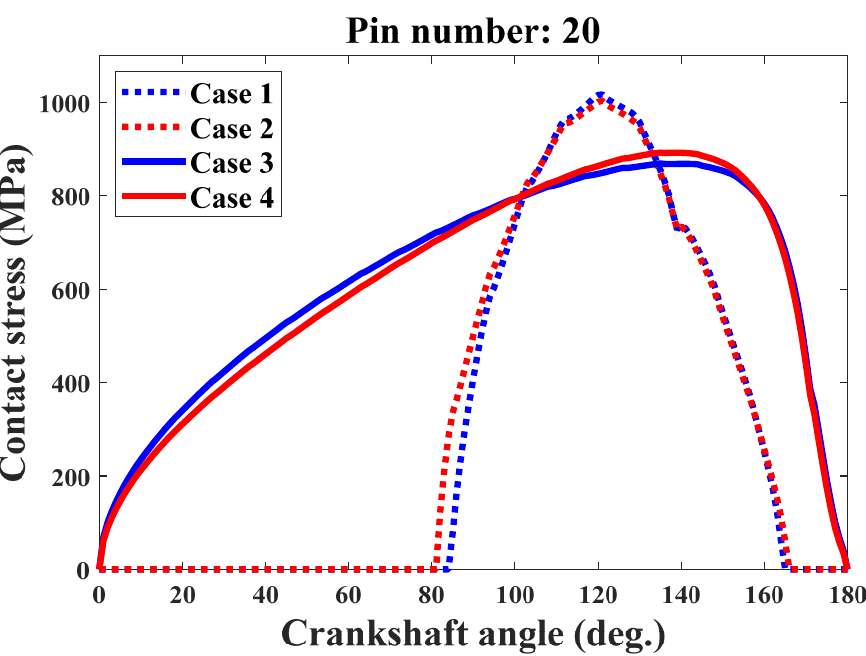
Figure 9. Comparison of the contact stress on pin number 20 within one mesh circle for four cases.